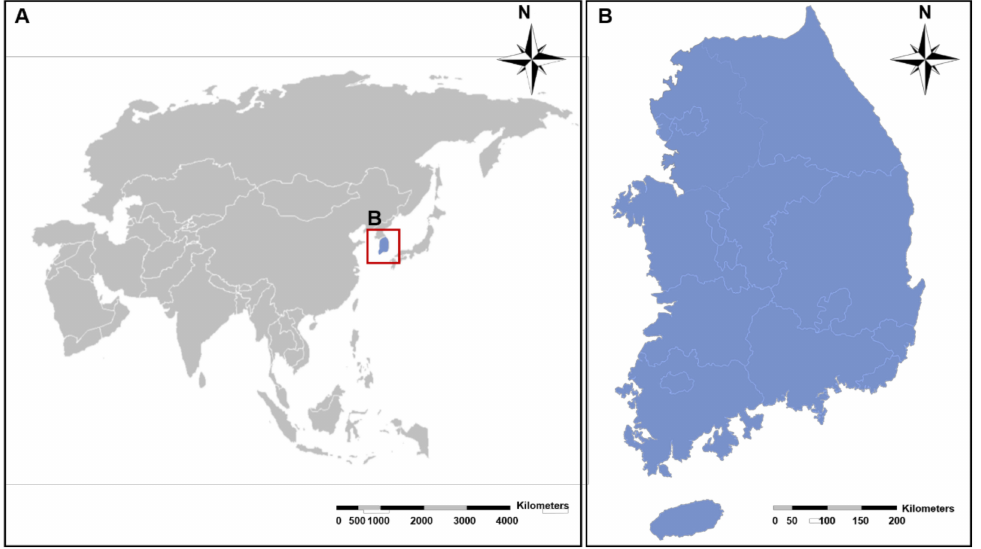
Figure 1. Study area: geographical location of ( A ) the continent of Asia, ( B ) the Republic of Korea. For the classification of households, the criteria defined in Korea’s housing policy were considered. One-person households are defined as households comprising one member regardless of the household owner’s age. Newlyweds are defined as couples within seven years of the marriage registration period. In the case of young households, youth is defined as those under 39 years of age. In this study, young households are defined as households with a household owner under 39 years of age. Further, those 65 years of age or older comprise the elderly, and elderly households are households whose owners are 65 years of age or older. The final sample included 1504 surveys from one-person households, 189 surveys from newlywed couple households, 473 surveys from households of young adults, and 1089 surveys from households of the